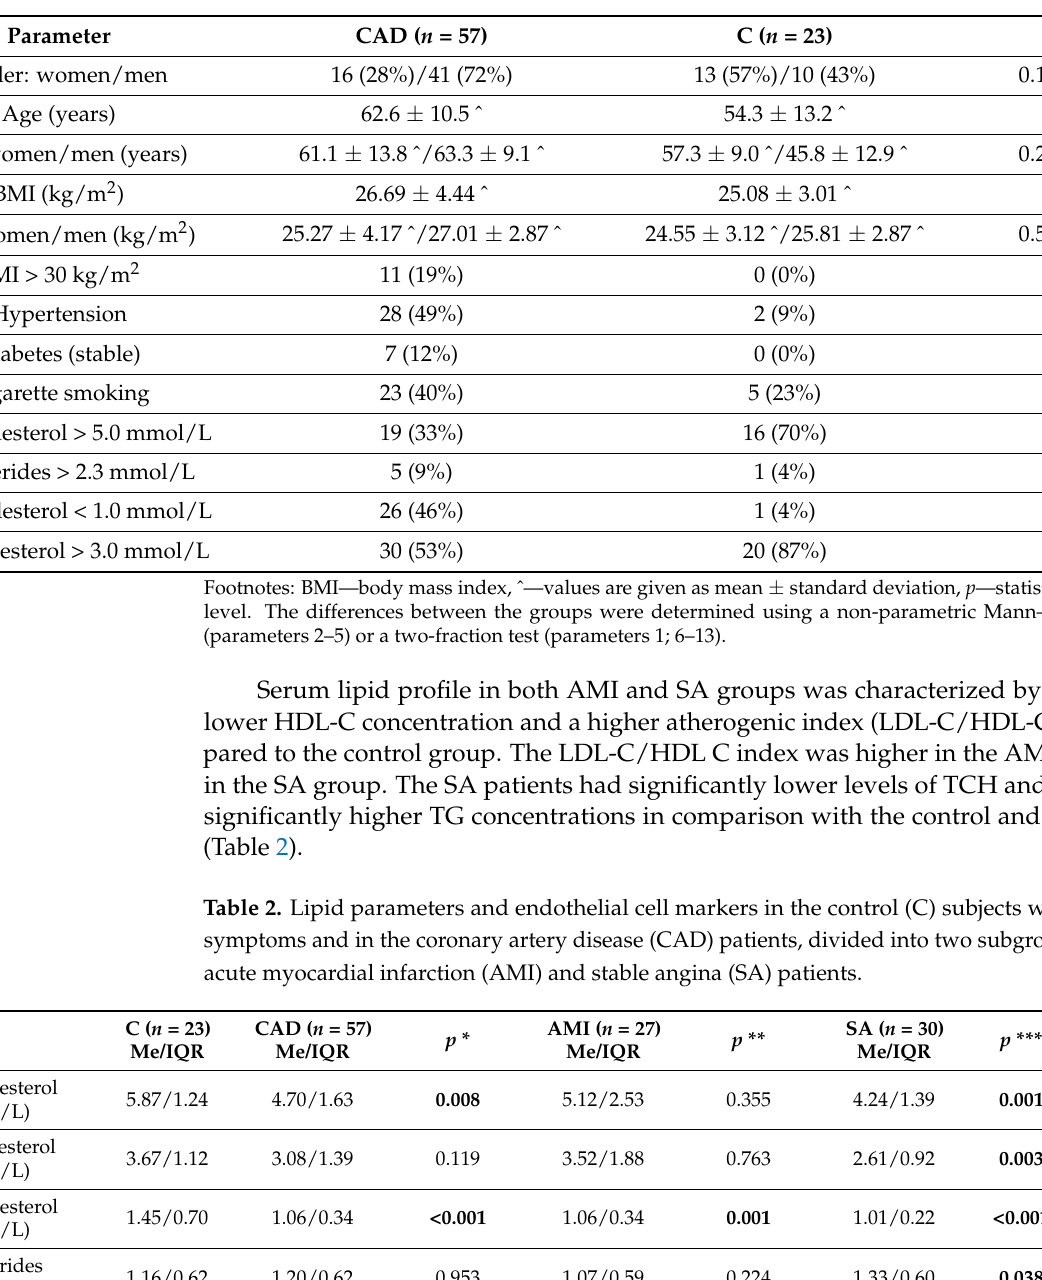
Table 1. Clinical characteristics of the coronary artery disease (CAD) patients and control subjects without cardiac symptoms (C).